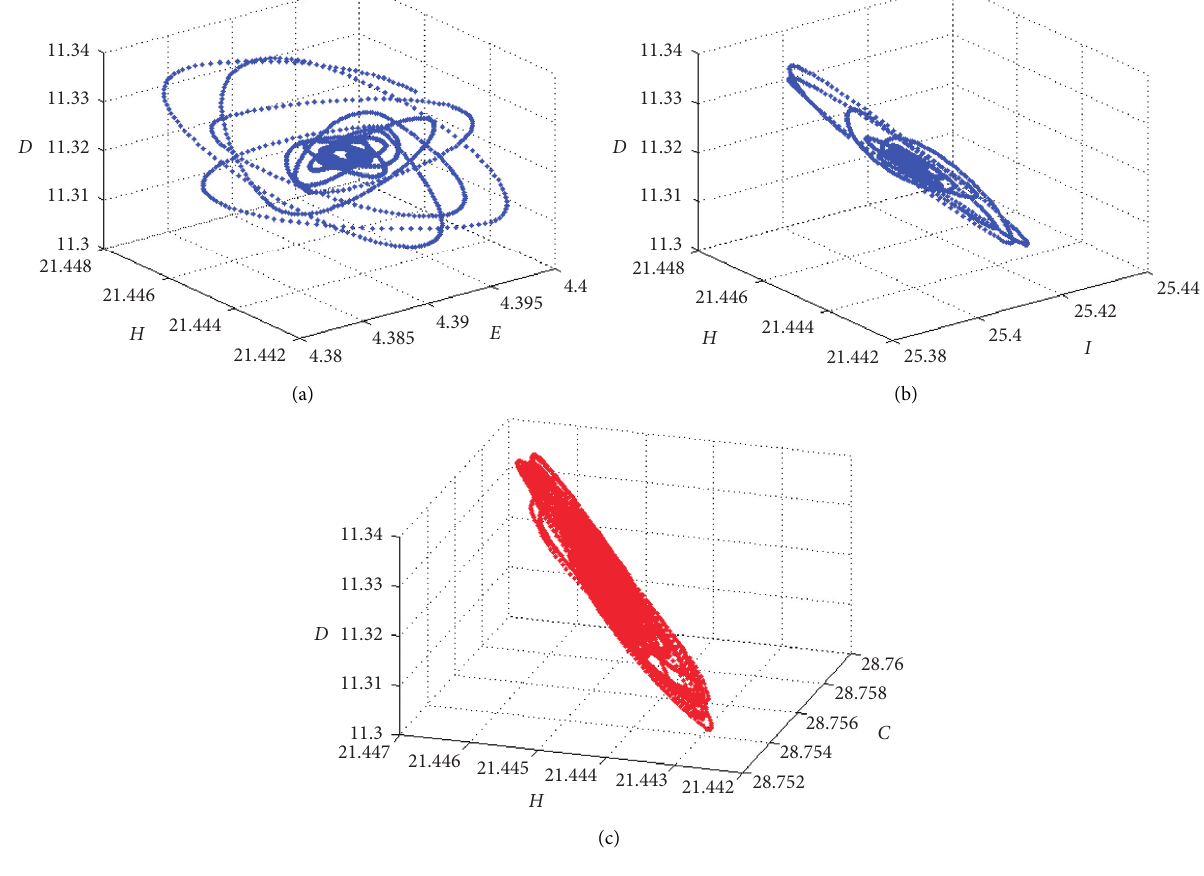
Figure 8: Scatter diagram for COVID-19